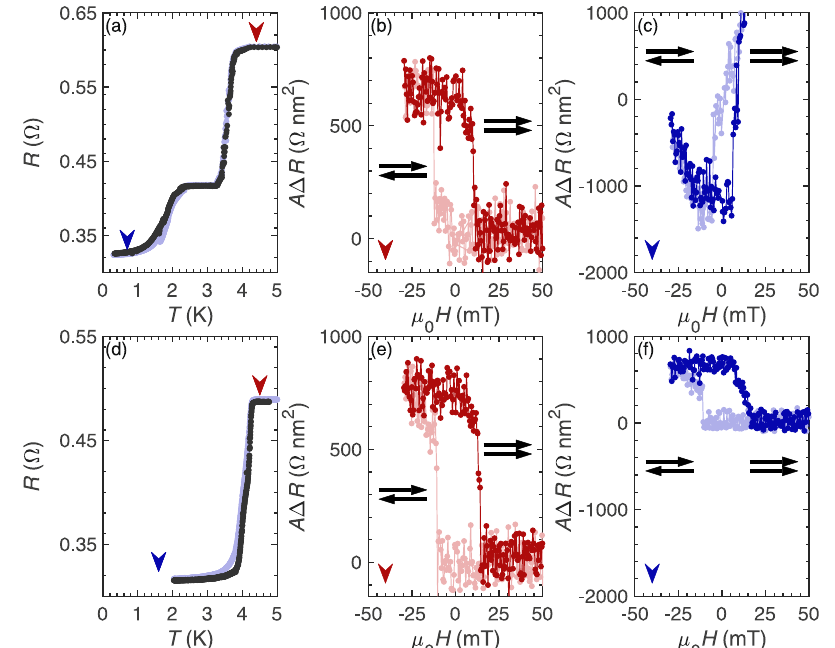
Fig. 2 R(T) and R(H) measurements for two spin-valve devices demonstrating different behaviours. The two different device responses observed. a Resistance ( R ) vs. temperature ( T ) curve for a device with Nb thickness d Nb = 25 nm, in both the parallel (black) and antiparallel (blue) states. b , c Minor R ( H ) loops ( μ H : in-plane magnetic fi eld) from the same device as ( a ), in the normal state, ( b ), showing giant 0 : magnetic permeability in a vacuum, magnetoresistance, and the superconducting ( c ) state, which has greater resistance in the parallel state. d R ( T ) curve for a device with d Nb = 28.5 nm, in both the parallel (black) and antiparallel (blue) states. e , f Minor R ( H ) loops from the same device as ( d ), in the normal state, ( e ), showing giant magnetoresistance, and the superconducting ( f ) state. In the superconducting state, the antiparallel state has higher resistance, similar to the normal state. For the R ( H ) loops, light data represent sweeps from positive to negative H , starting at high positive values. The dark data in each loop is for the return sweep. In these minor loops, only the free permalloy layer undergoes switching, illustrated by the black arrows, which show the relative magnetic moment orientation of the permalloy layers. Arrows in a , d indicate the temperature of the corresponding R ( H ) loops. Supplementary Fig. 1 features b , f with different axes, and Supplementary Fig. 2 features similar plots for two additional